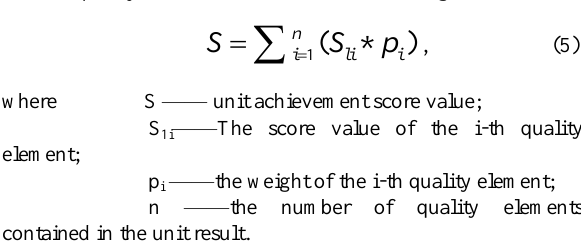
Table 7. Types of errors and omissions and deduction criteria (4) The quality of unit results is scored according to formula (5).